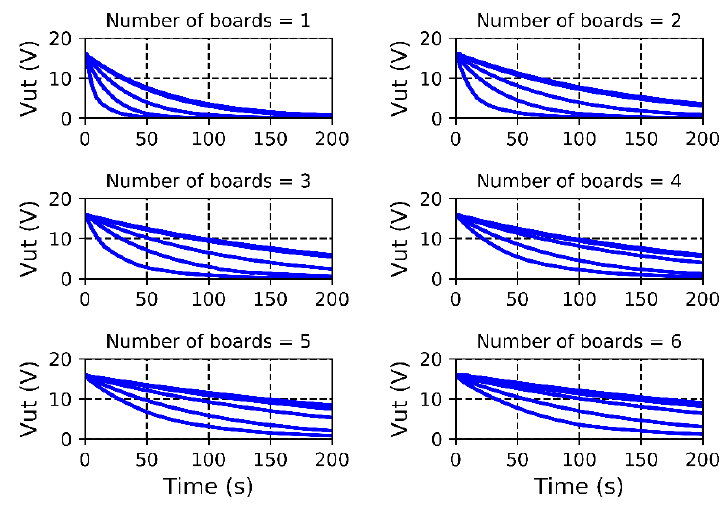
Figure 25. Voltage while discharging according to the number of boards connected.